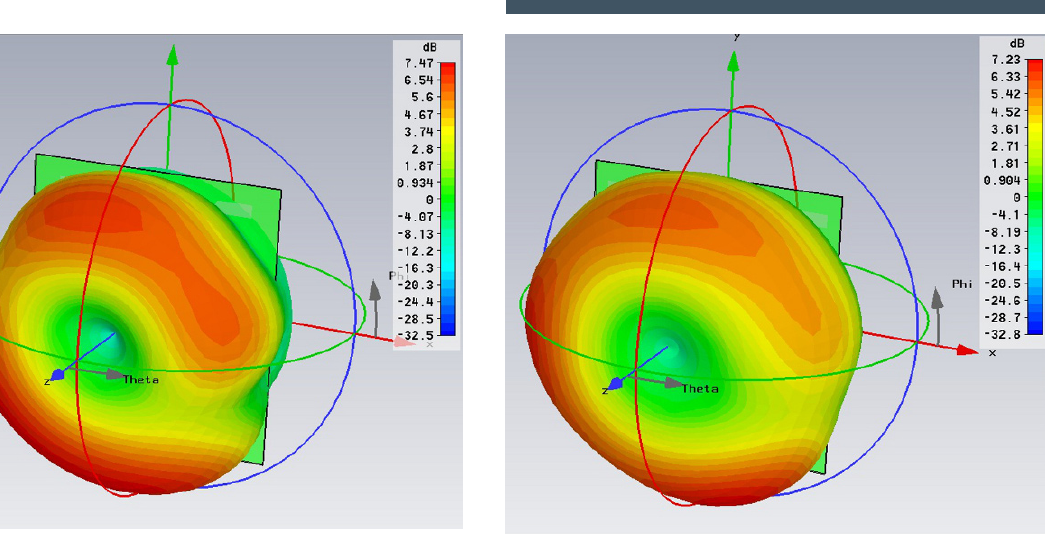
Figure 13. Radiation pattern for 70°.